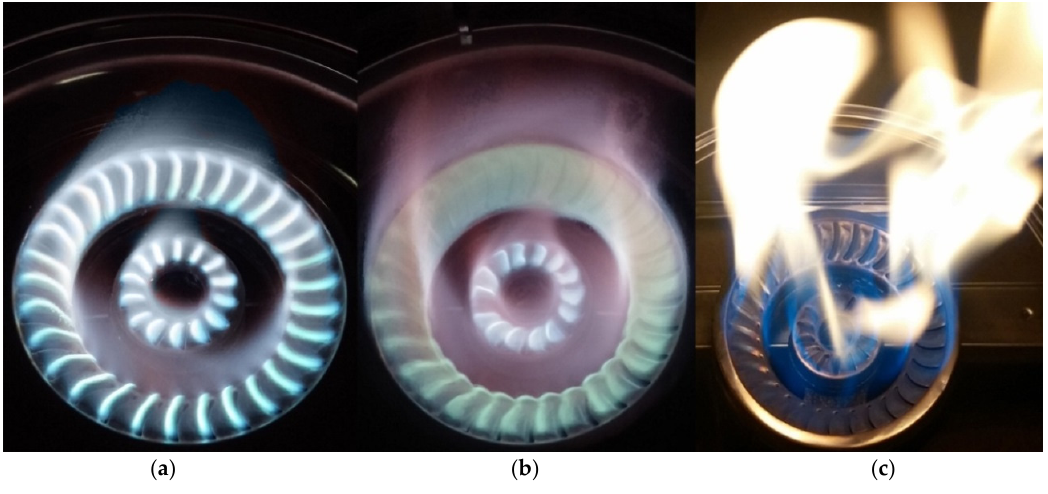
Figure 8. Visible flame appearances of CH 4 :air mixture combustion.